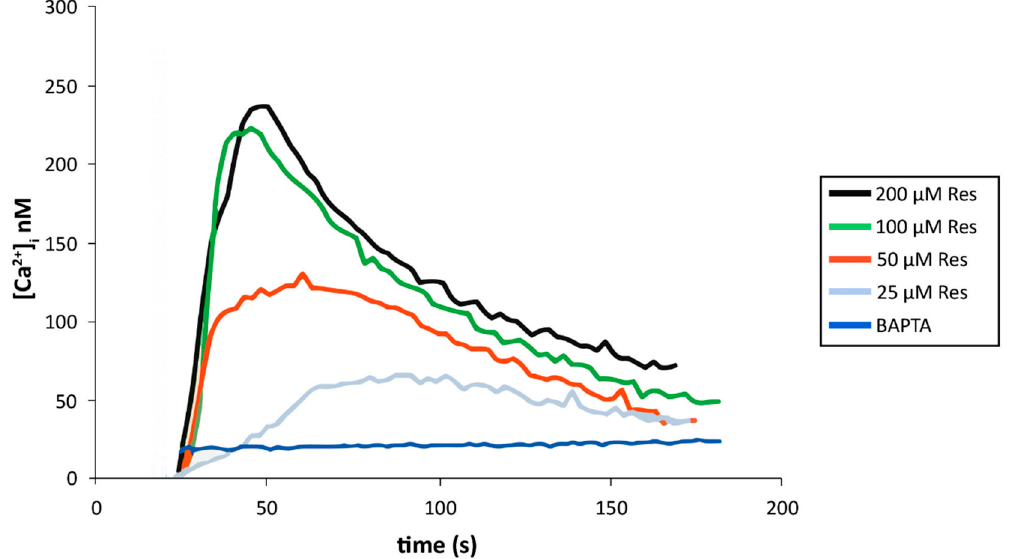
Figure 11. Resveratrol increases cytoplasmic calcium in activated endothelial cells.